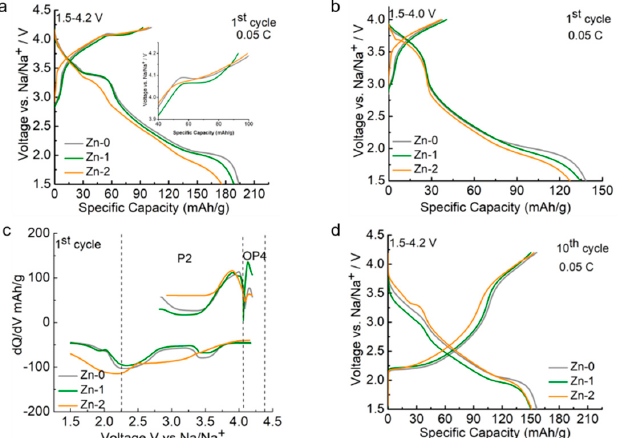
Figure 8. Charge–discharge profile curves for Zn-0, Zn-1 and Zn-2 cathodes cycled between 1.5–4.2 V vs. Na/Na + at 0.05 C. ( a ) First cycle, the inset image shows a smooth curve for Zn-2 electrode compared to Zn-0 and Zn-1. ( b ) First cycle in the voltage range of 1.5–4.0 V vs. Na/Na + . ( c ) dq/dv plot in the voltage range of 1.5–4.2 V for first cycle. ( d ) 10th cycle in the voltage range of 1.5–4.2 V vs. Na/Na +